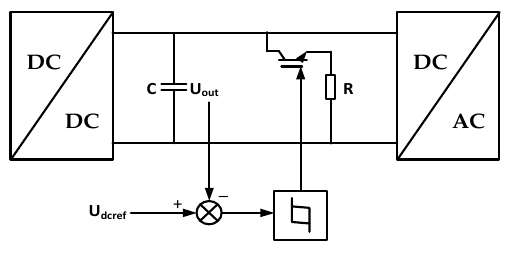
Figure 4. DC–chopper protection circuit.